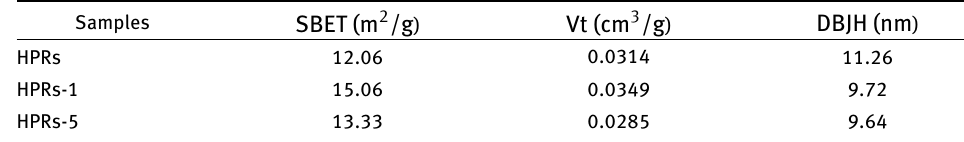
Table 3: The porous parameters of HPRs, HPRs-1 and HPRs-5